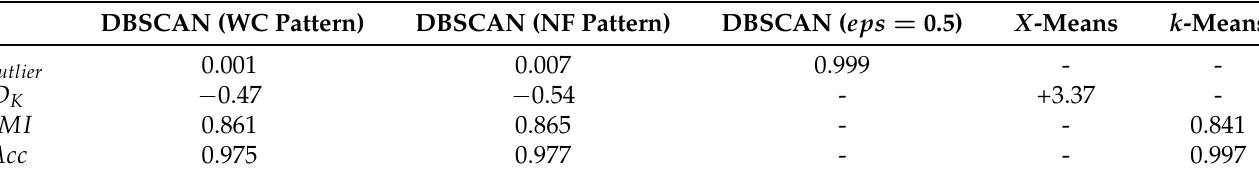
Table 5. Each evaluation parameter of DBSCAN (dataset